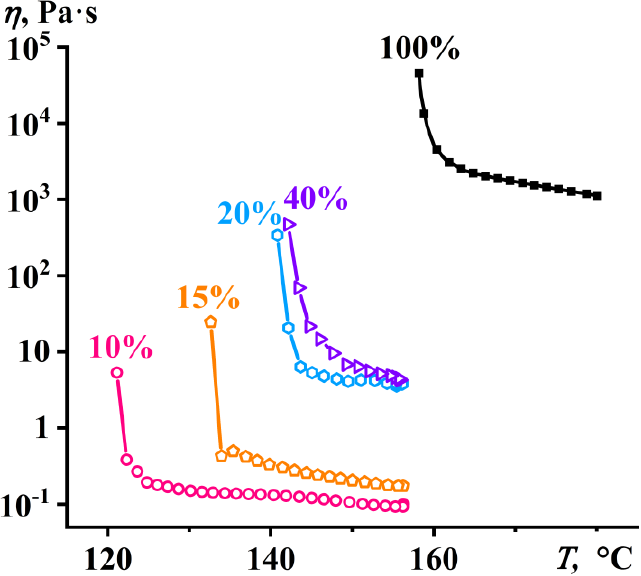
Figure 5. Temperature dependences of the effective viscosity of the polylaurolactam solutions in benzyl alcohol obtained in the cooling mode at a constant shear rate of 0.1 s −1 . The concentration of polylaurolactam is provided near the curves.